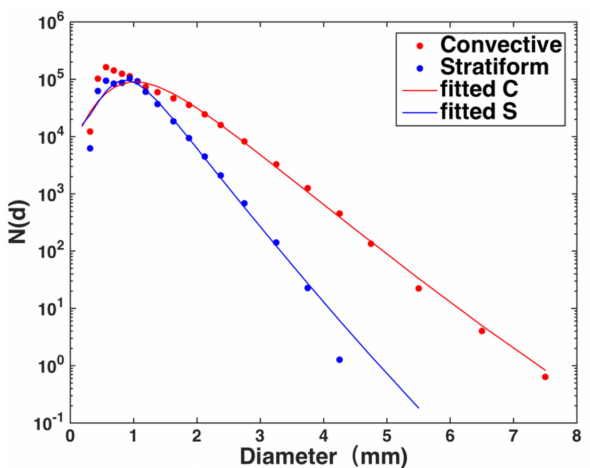
Figure 7. Composite raindrop spectrum for convective and stratiform rain types. The red line is the gamma function fitted on convective spectrum using the second, fourth and sixth moment method and the blue line is for the stratiform